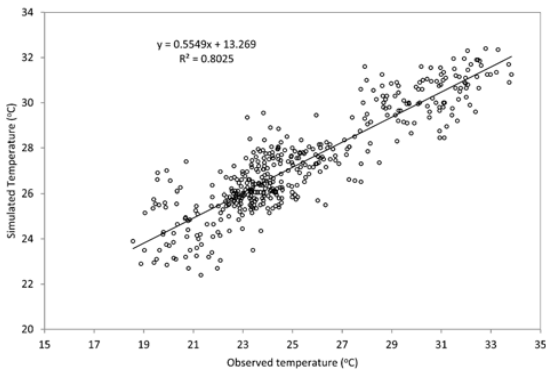
Figure 5. Comparison between observed and simulated temperature (°C) by SMHI-ECHAM (1970–2005).